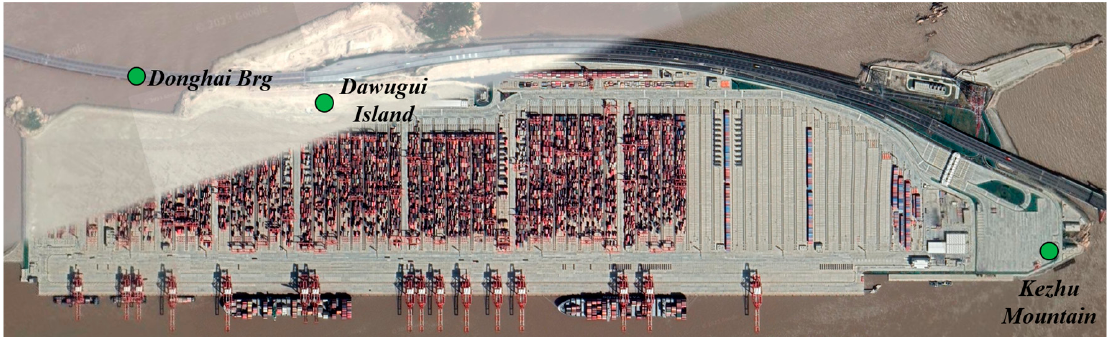
Figure 1. Phase IV wharf of Yangshan Port.